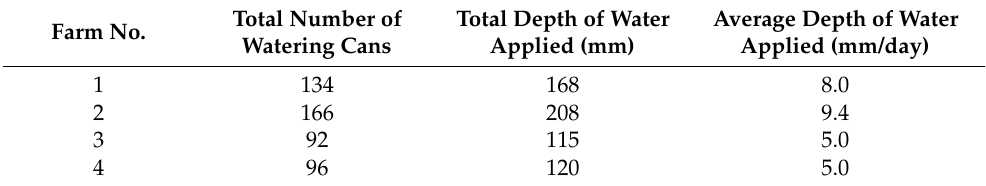
Table 4. Total depth of water applied to similar crops in the same growing season on four farms in Chhouk, Kampot province,